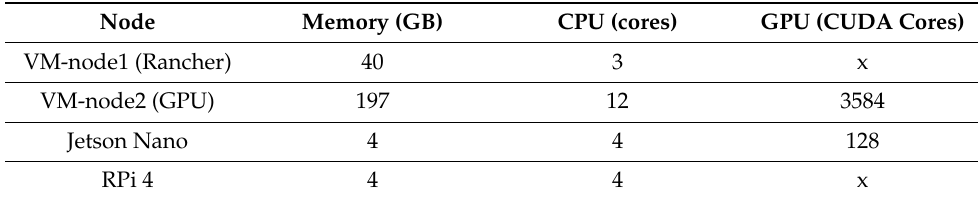
Table A1. HW capabilities of the nodes in terms of memory, CPU and GPU/CUDA cores. Node